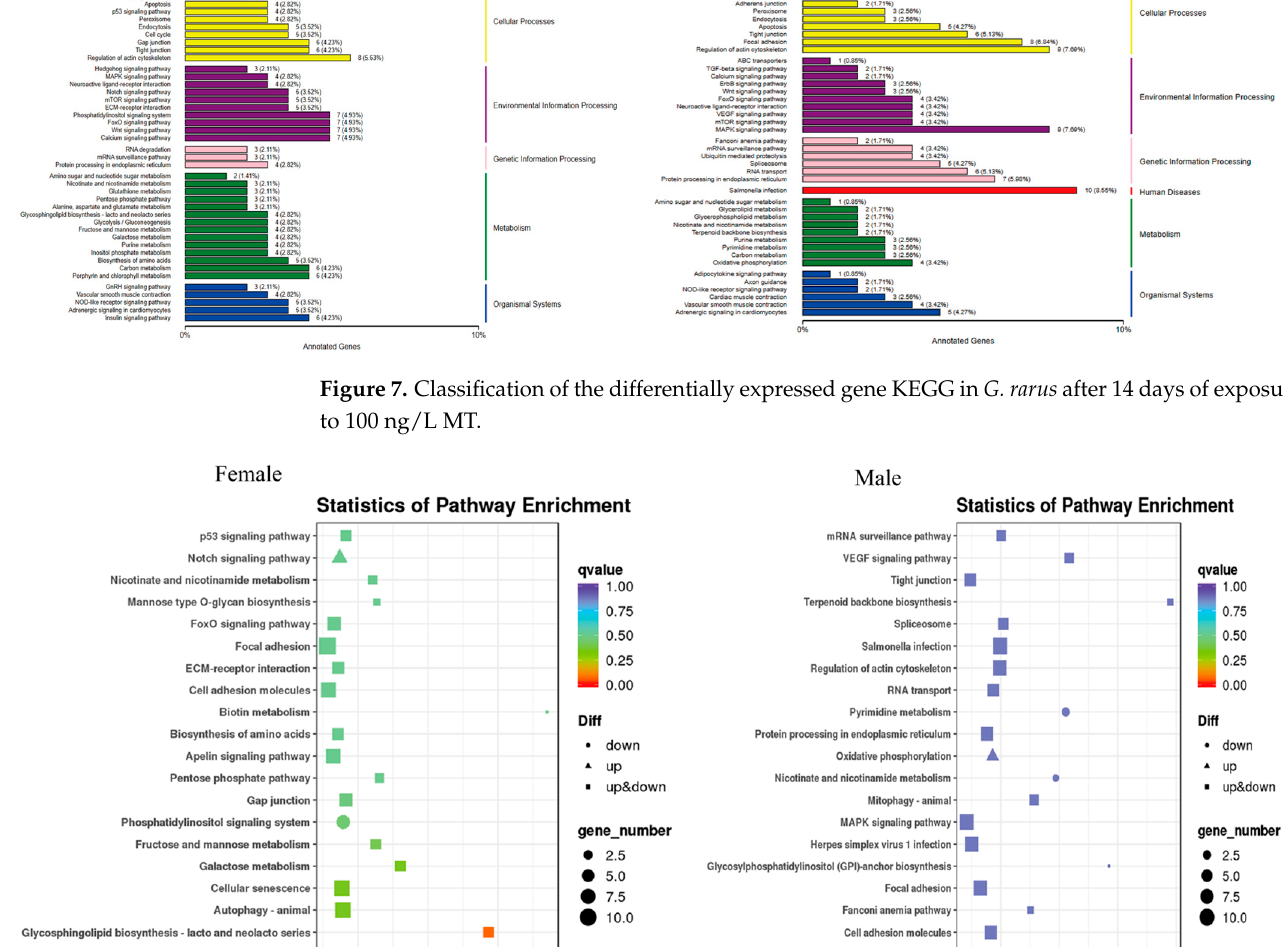
Figure 8. Scatter plot of the differentially expressed gene KEGG pathway in G. rarus after 14 days of exposure to 100 ng/L MT. Table 1. Verification of differential expressed genes in G. rarus using qRT-PCR. Negative values indicate the down-regulation of expression, whereas positive values indicate the up-regulation of expression. Sex Gene Gene ID Fold by RNA-Seq Fold by